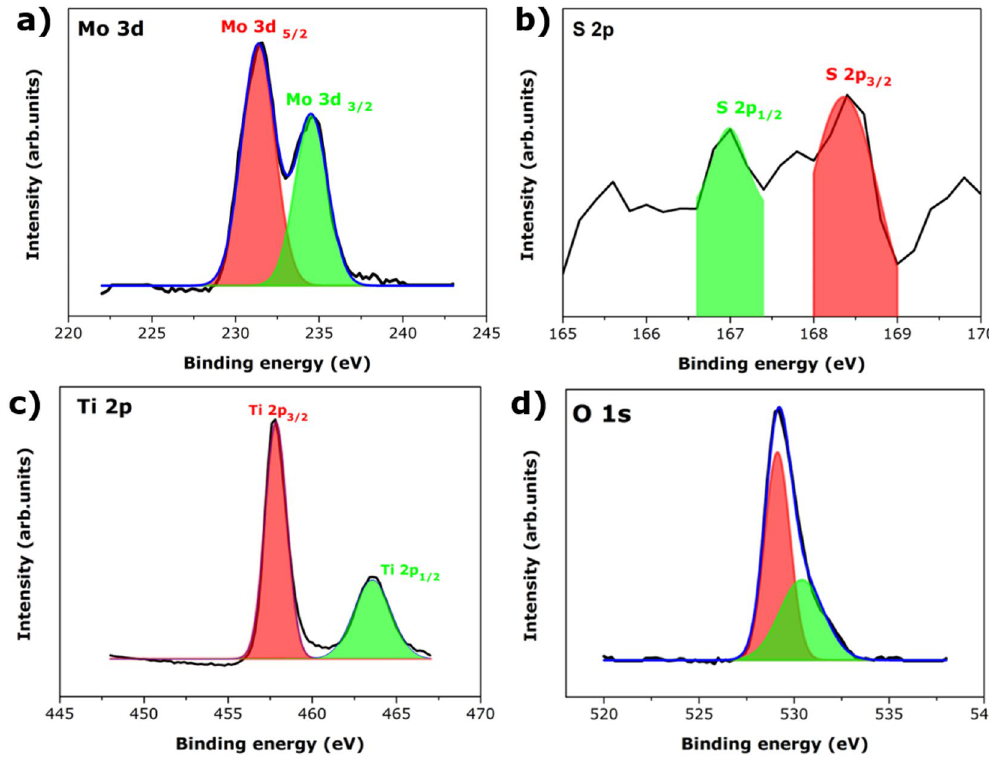
Figure 2. XPS spectrum of L-cysteine capped MoS 2 @TiO 2 nanostructures